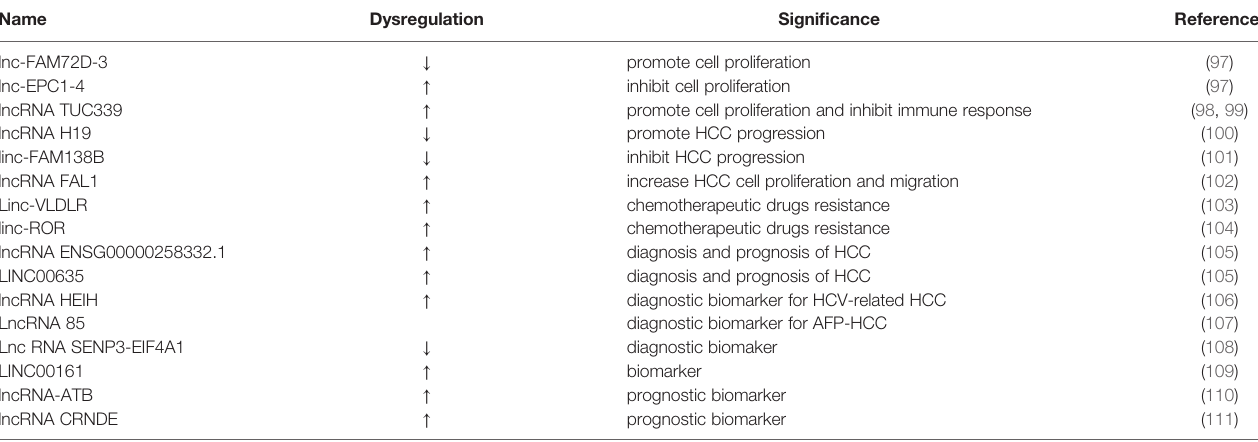
TABLE 1 | Biological functions and clinical applications of exosomal LncRNAs in liver